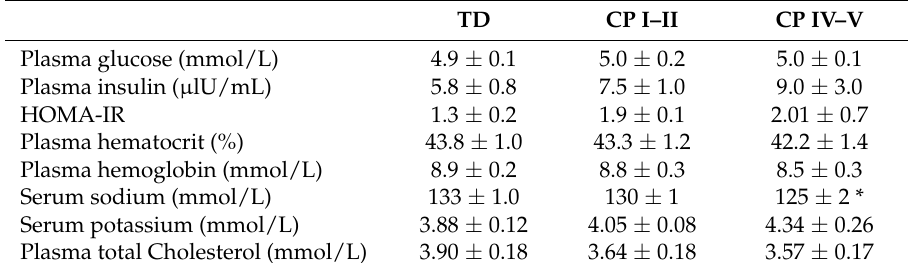
Table 5. Fasting blood values.